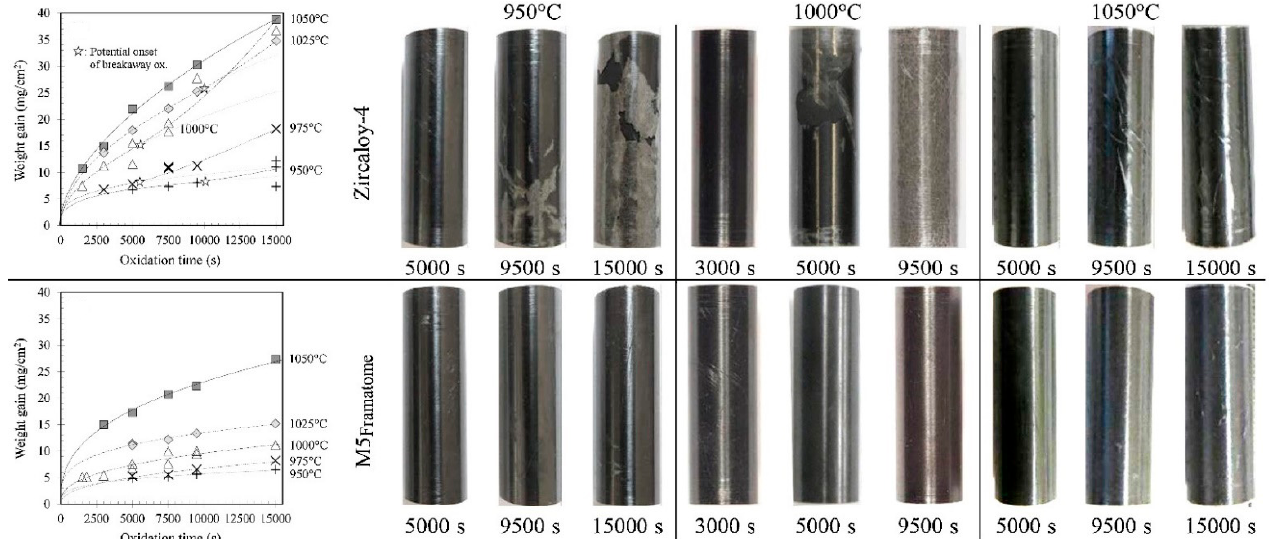
Figure 2. Post-quenching view of oxidized Zircaloy-4 and M5 (Framatome) cladding tube samples, oxidized in steam at 950–1050 °C. Reproduced from [60] with permission by Elsevier.